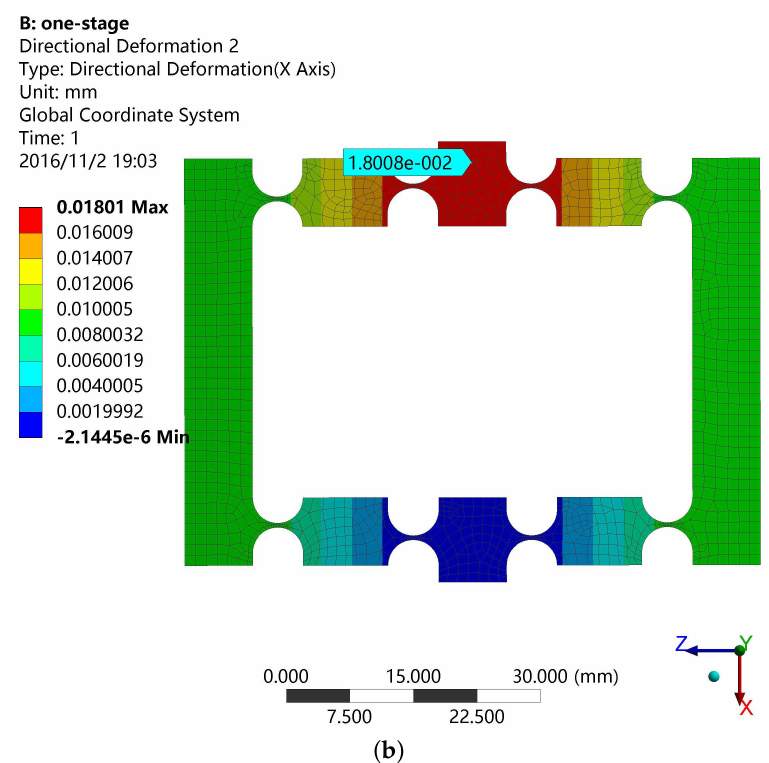
Figure 3. The basic bridge amplifier with right circular hinges. ( a ) The deformation in the z -direction; ( b ) the deformation in the x -direction.